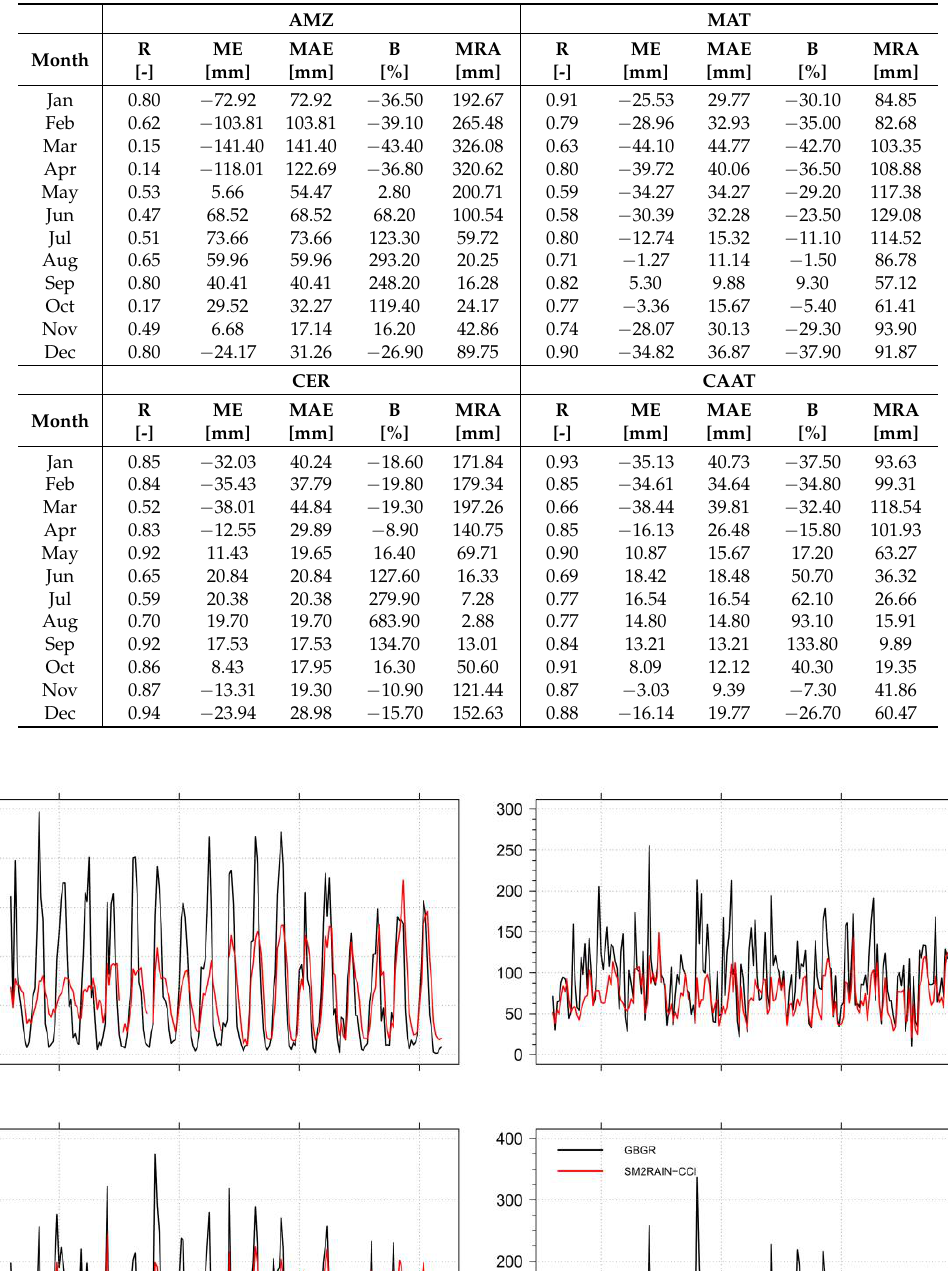
Table 6. Correlation coefficients (R), mean error (ME), mean absolute error (MAE), and percent bias (B) for the 5-day accumulated rainfall estimates derived from SM2RAIN-CCI against observations from the GBGR data over the main biomes of NEB during the period 1998–2015. The monthly rainfall average (MRA) is based on the GBGR data. For each score, the median value is reported. AMZ